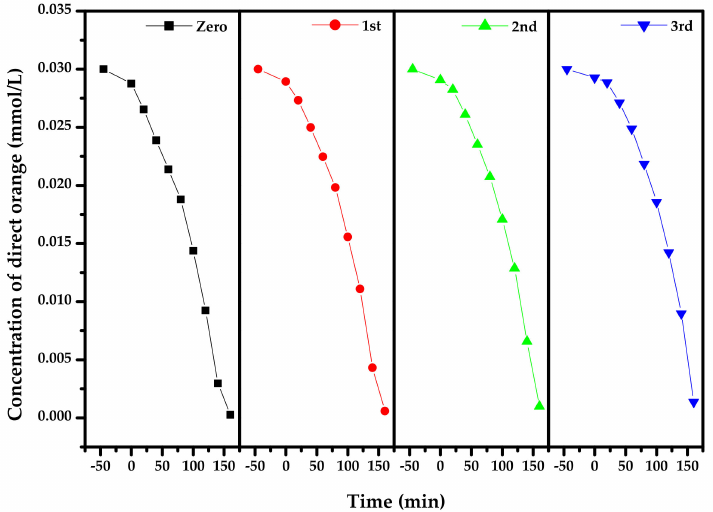
Figure 14. Concentration variation curves of DO during PD of DO in dye wastewater with Bi 2 SmSbO 7 /ZnBiYO 4 heterojunction as photocatalyst under VLI for three cycle degradation